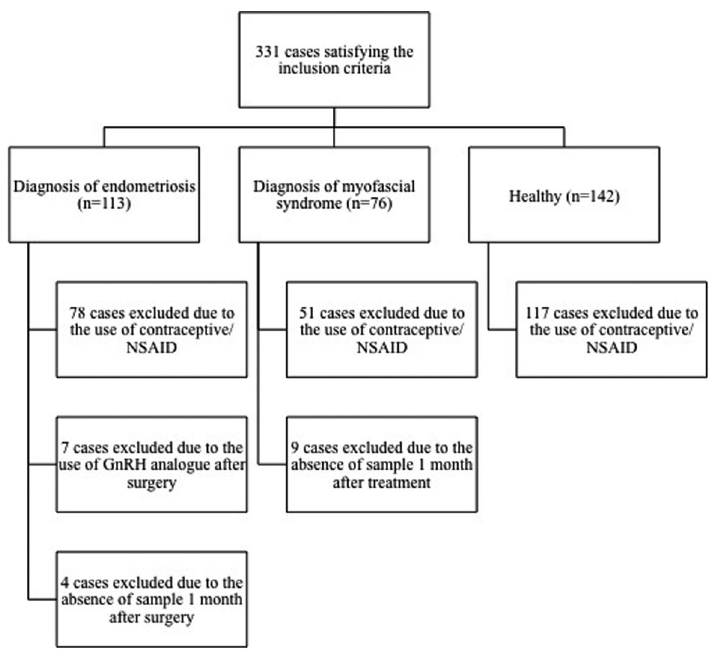
Figure 1. Flow diagram of the recruitment of subjects and